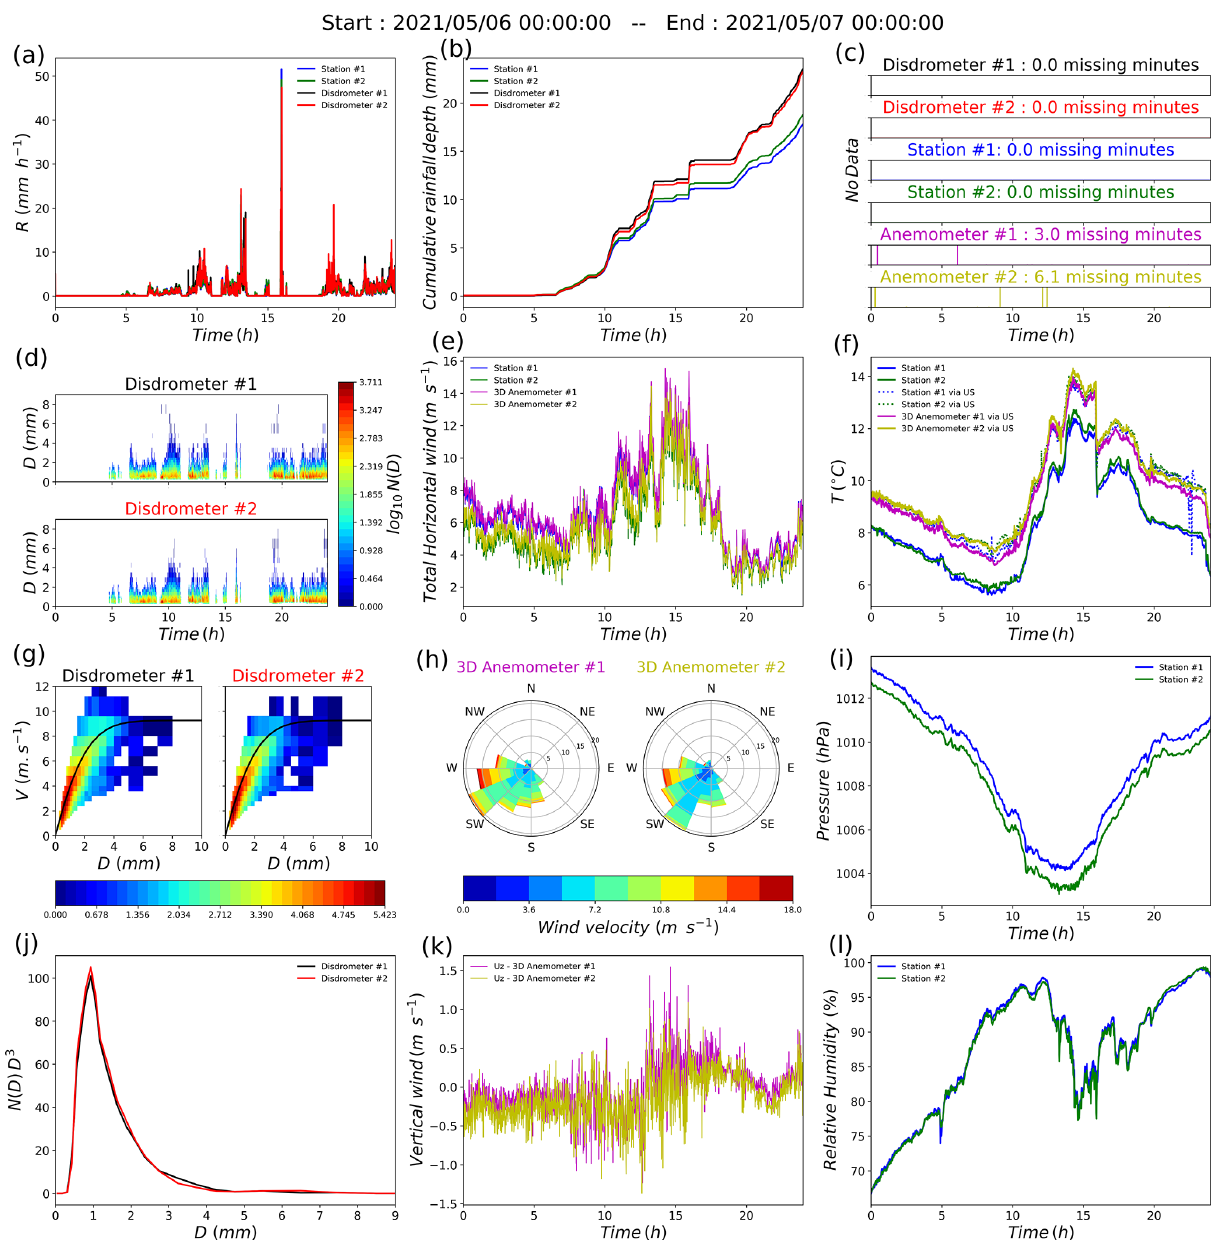
Figure 8. Quick look of the meteorological data available on 6 May 2021. A precise description of each panel is given in the text.